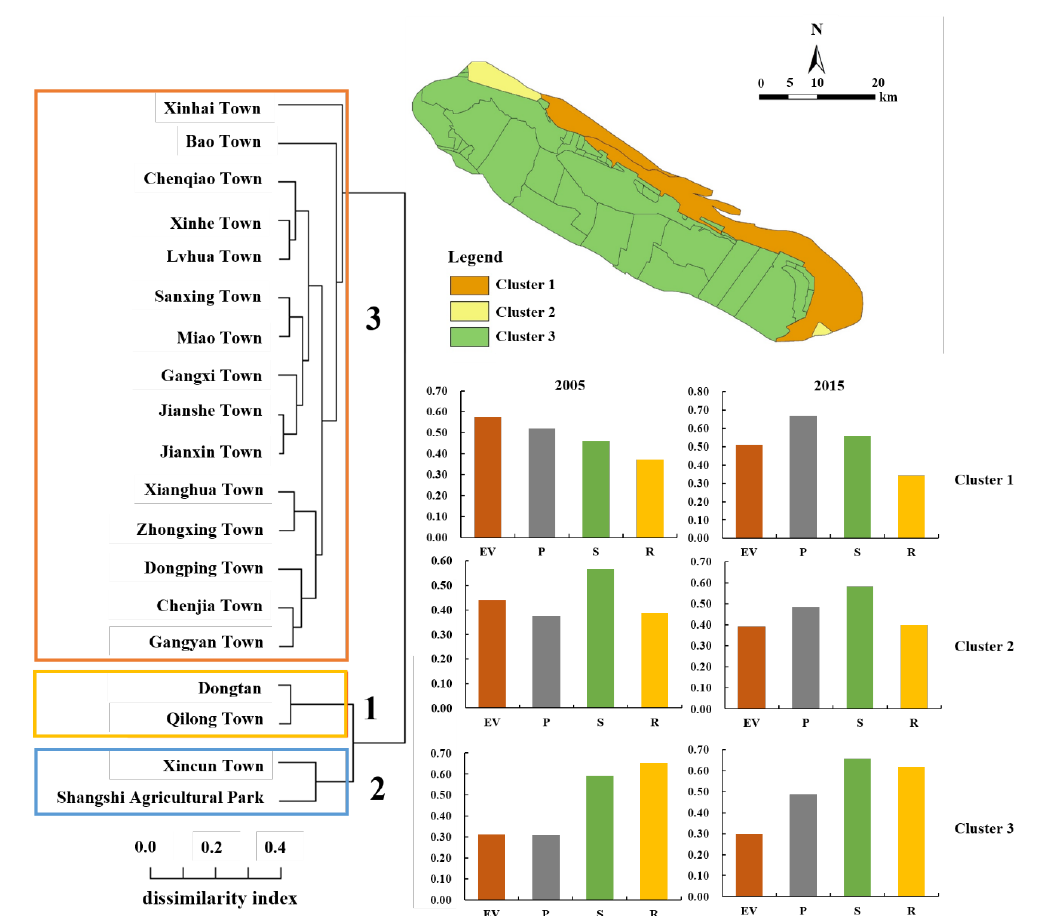
Figure 5. The results of the Chongming Island town clusters based on ecological vulnerability assessment in 2010 and 2015.